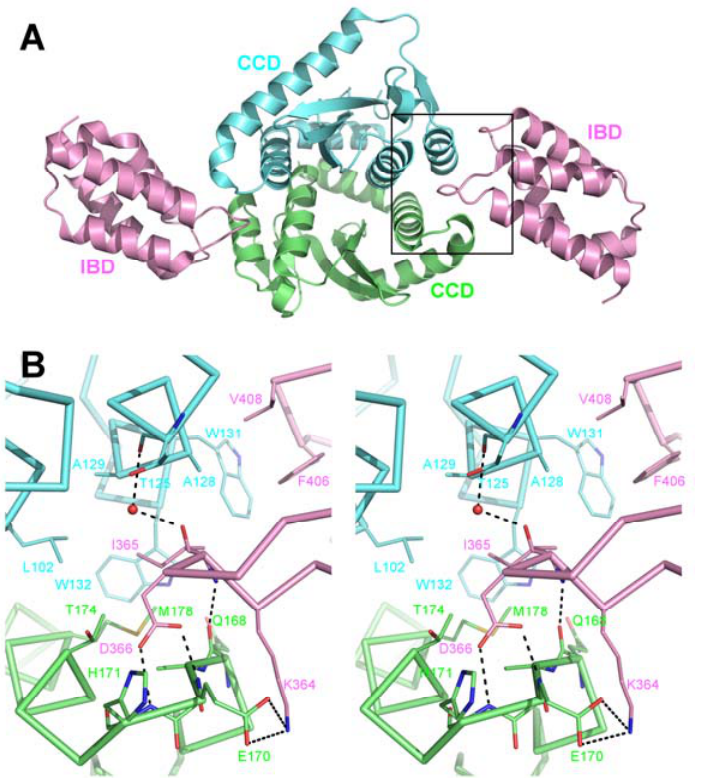
Figure 4. The primary IN:LEDGF interface. A. Cartoon representation of the co-crystal structure of the IN :LEDGF complex (PDB ID 2b4j). IN chains are colored green CCD IBD (chain A) and cyan (chain B) and a pair of LEDGF chains interacting at either end of the IN CCD dimer are pink. B. Stereo close-up view of the region enclosed by a black rectangle in A , showing details of the CCD:IBD interface. The protein backbone and side chains, shown in ribbon and stick representations, respectively, are colored by atom. Side chains of residues involved in interactions are shown, as well as a water molecule coordinated between main chain carbonyls of IN Thr-125 and LEDGF